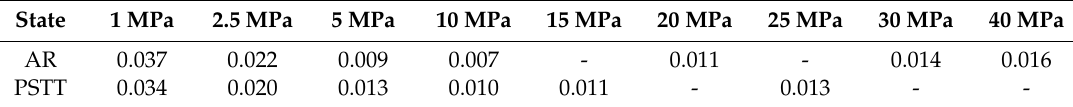
Strip drawing test friction coe ffi cient values for both material surfaces at di ff erent contact pressures.